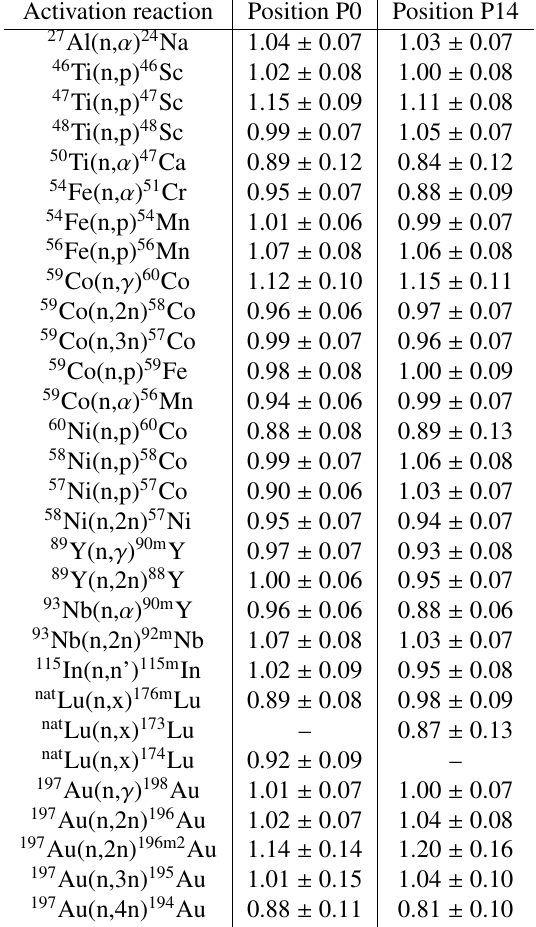
Table 2. Calculated-to-experimental reaction rates ratios for deconvoluted neutron energy